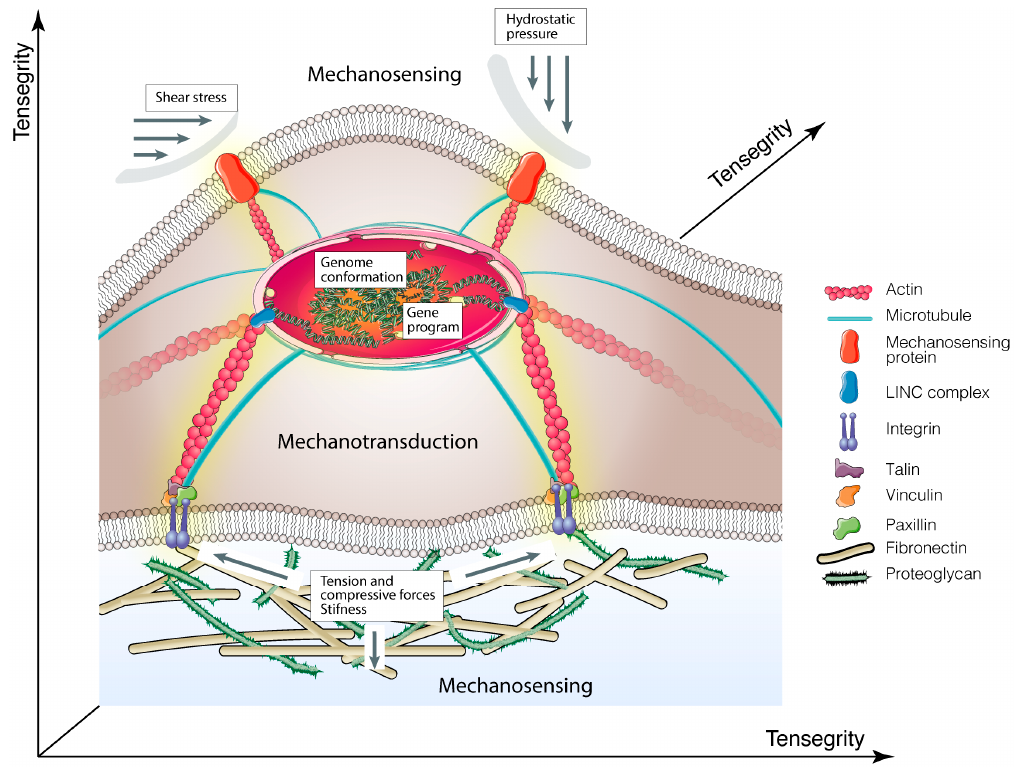
Figure 1. Schematic illustration of molecular basis of mechanobiology. Cartoon shows how mechanical cues are transmitted to the nucleus via integrins > focal adhesion complex > cytoskeletal components > nucleoskeleton. The yellow shadow indicates mechanotransduction signals.